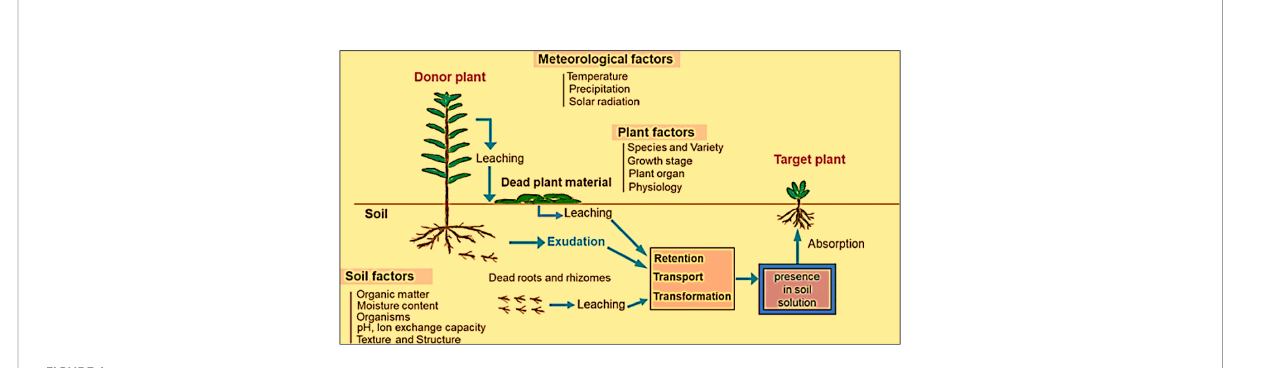
FIGURE 1 Pathway of allelochemical release from plants (Source: Retrieved and modi fi ed from Scavo et al.,